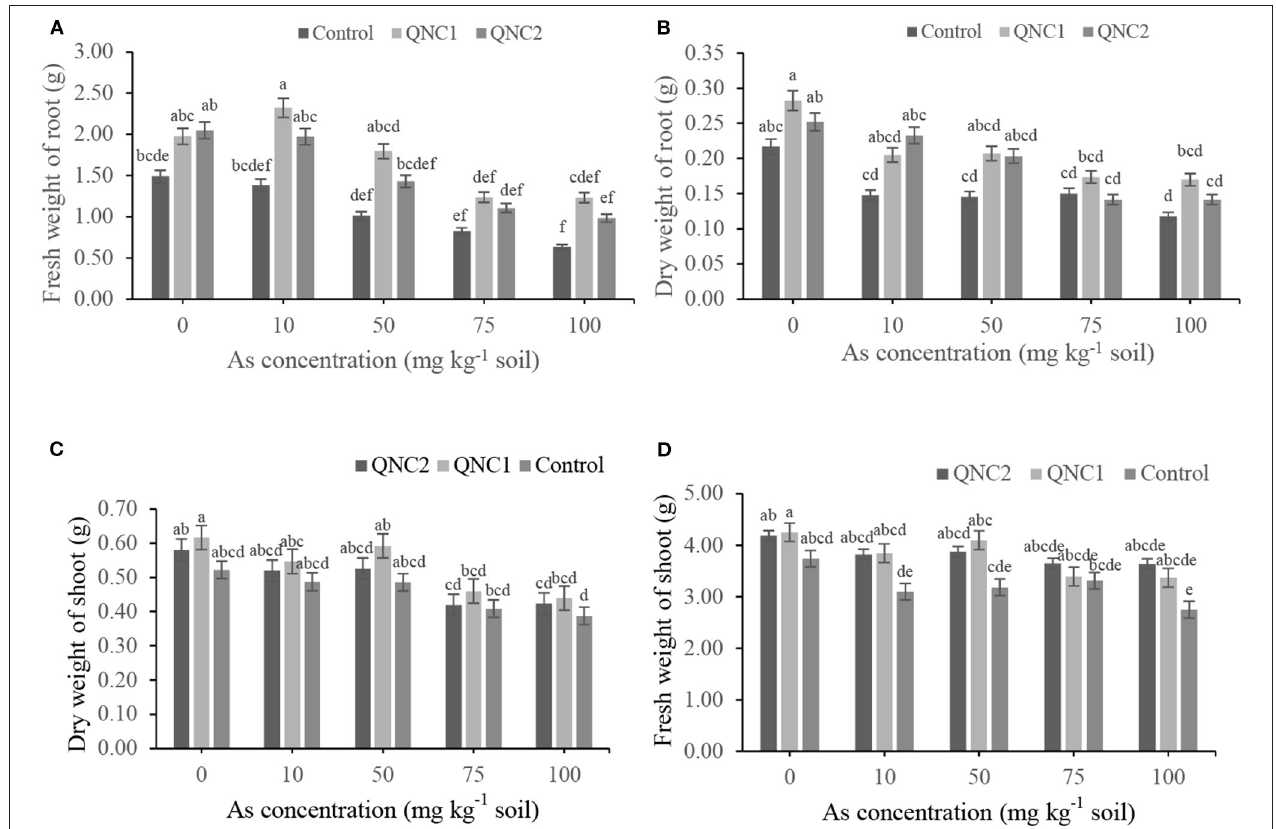
FIGURE 5 | Effect of different sodium arsenate concentrations on (A) the fresh weights of roots, (B) dry weights of roots (C) fresh weights shoot and (D) dry weights shoot biomass of chickpea plants treated with Pseudomonas sp. QNC1 and Rahnella sp. QNC2. Data are the mean of three individual repetitions. Error bars indicate a standard error, and different letters above error bars represent significant differences based on a least significant difference (LSD) test (P = 0.05).